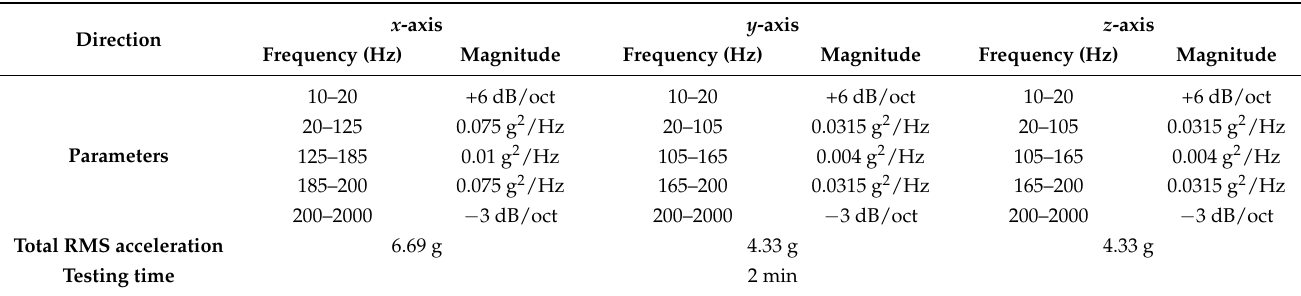
Table 4. Random vibration test conditions.